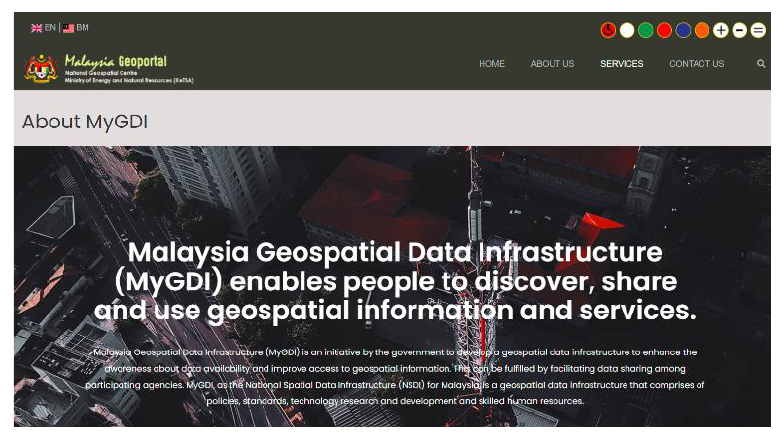
Figure 3. Malaysia ’ s geospatial data infrastructure [11]. Figure 3. Malaysia’s geospatial data infrastructure [11]. With the Development Administration Circular No. 1 of 1997, the SDI approach was conceived in 1997 under the National Infrastructure for Land Information System/NaLIS cover. As the demand increased, the Malaysian Centre for Geospatial Data Infrastructure (MaCGDI) was established in 2002 to strengthen the coordination of SDI modernisation and development.